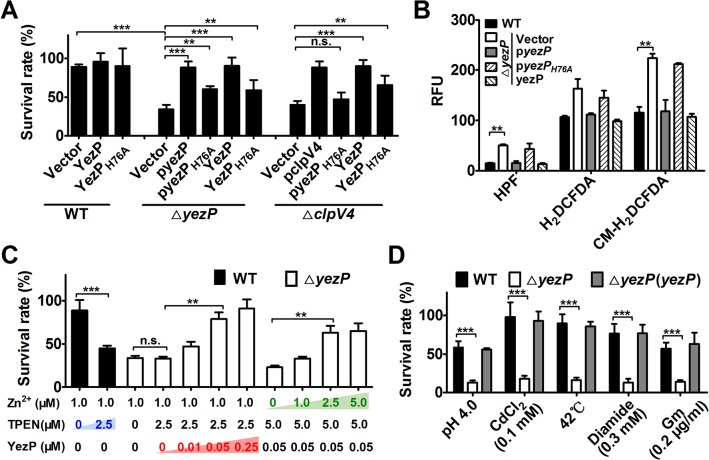
The activity of YezP in Yptb resistance to stresses.
A. The rescue of the yezP mutant or a T6SS-4 mutant by recombinant YezP. 0.05 μM recombinant YezP or YezPH76A was added to bacterial survival experiments before viability assessment. Mutants complemented with the corresponding gene were used as controls. Note the partial activity of YezPH76A. B. Deletion of yezP led to accumulation of intracellular ROS. Analysis of the mutants was performed as described in Fig 3 with the indicated fluorescence dyes. C. Recombinant YezP rescued the inhibition effects of a zinc chelator. TPEN and the indicated amounts of YezP or Zn2+ were incubated with bacterial cells prior to survival determination. D. yezP is required for the resistance to distinct cellular insults by Yptb. Bacteria were subjected to treatment with the indicated agents or conditions before determining bacterial survival rates. Gm, gentamicin. Data shown were the average of three independent experiments; error bars indicate SD from three independent experiments. ***, p<0.001; **, p<0.01; n.s., not significant.